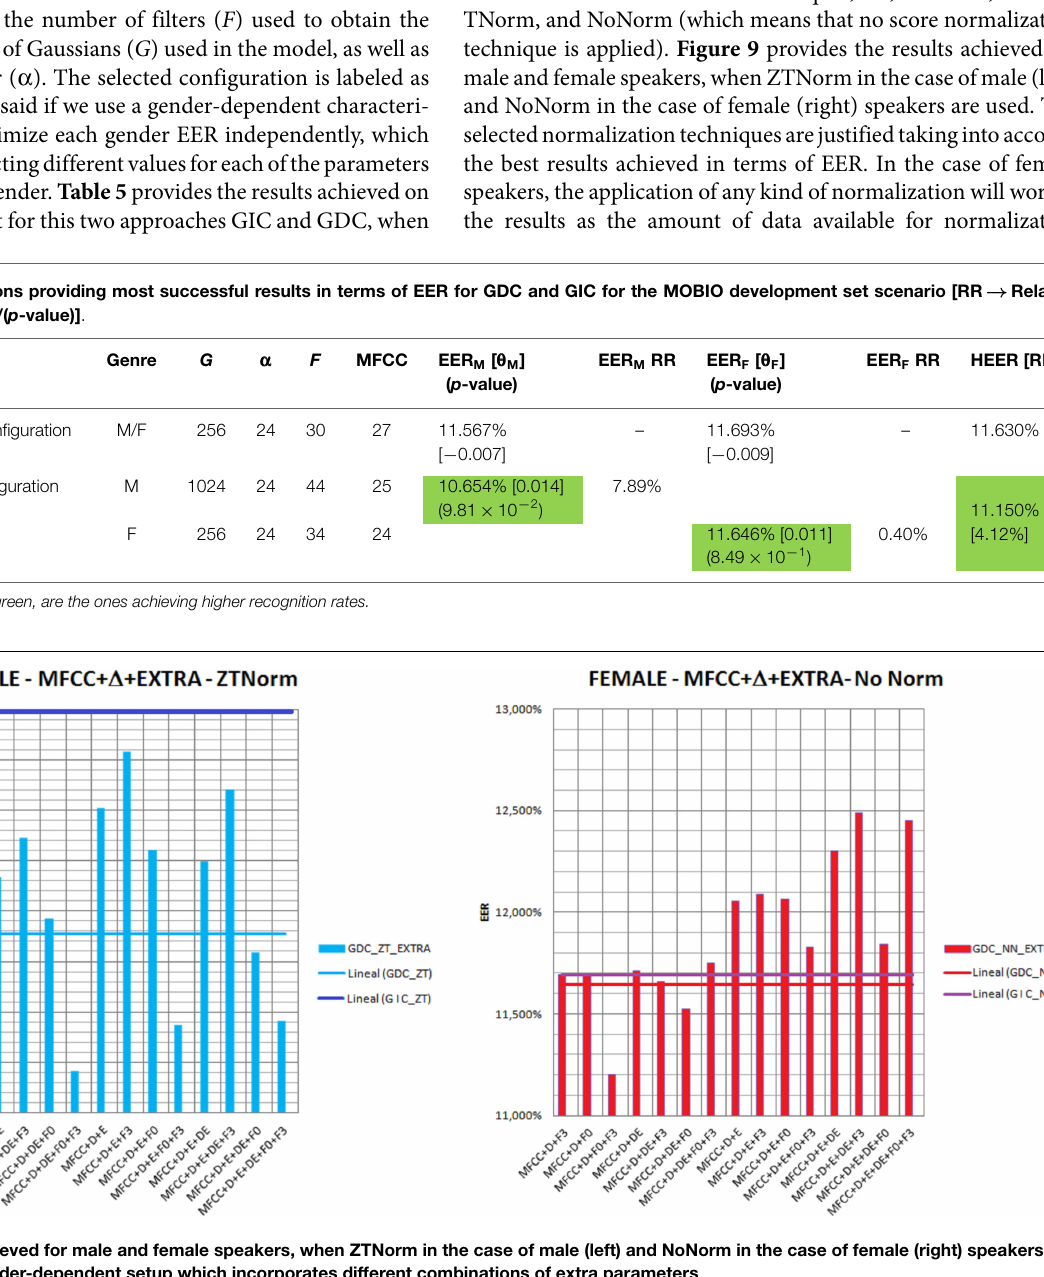
Frontiers in Bioengineering and Biotechnology |